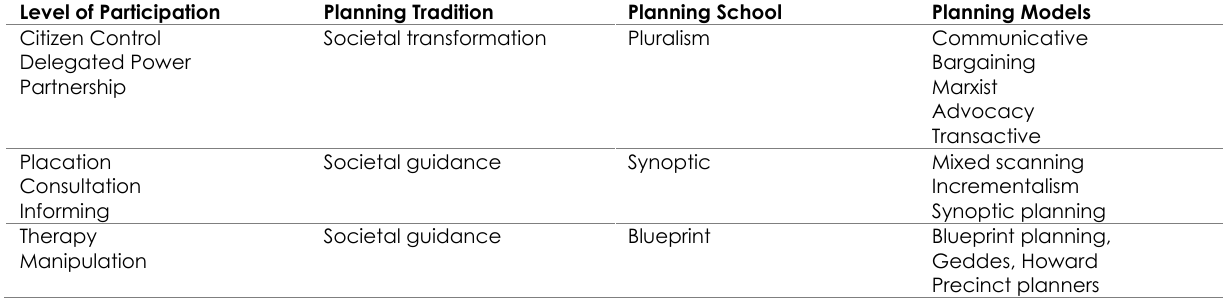
Table 1. Planning Approaches and Relation with Public Participation (Arnstein, 1969; Friedmann, 1987; Hall, 1992 as cited in Lane, 2005). Level of